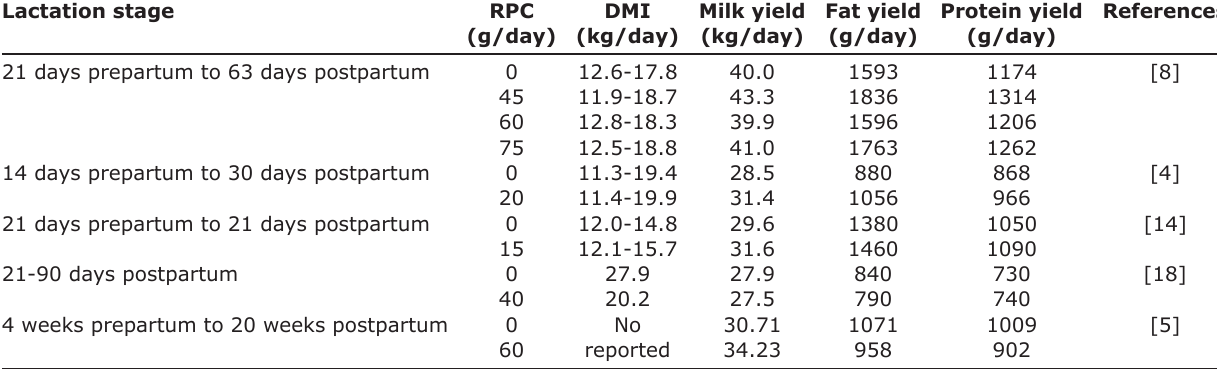
Table-3: Summary of studies on the impact of supplementation of RPC on milk production and composition on the lactating dairy cow. Lactation